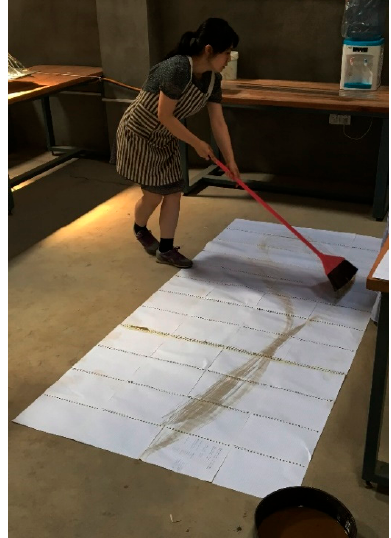
Figure 10. Calligraphic sketch (2017) by Ayako Tani.